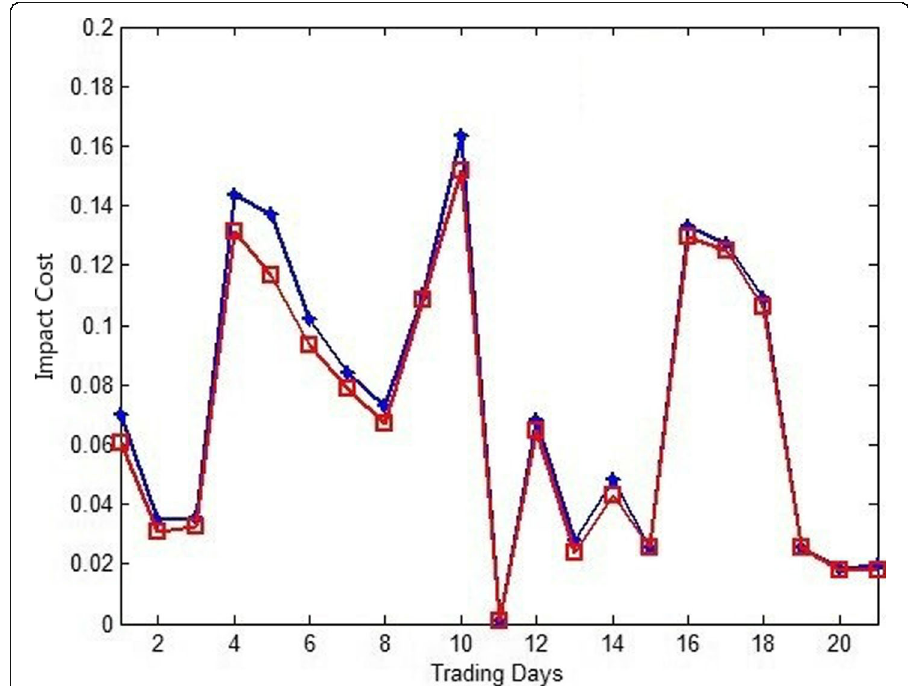
Fig. 8 Average impact costs of the arbitrage strategy and the other strategies. Red line: arbitrager strategy; Blue line: other strategies, include informed strategy, technical strategy and noise